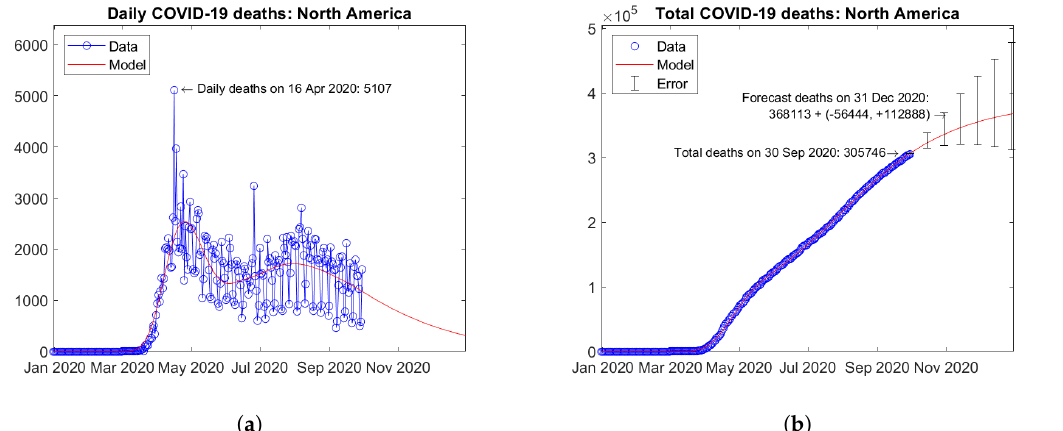
Figure 20. Actual and predicted trends in North America: ( a ) total deaths; ( b ) daily